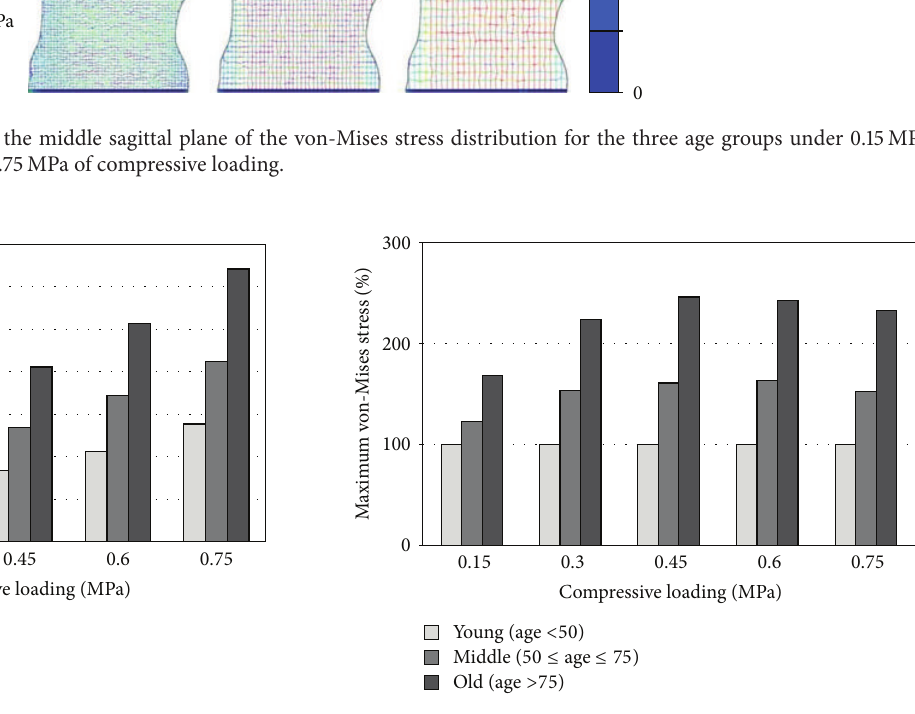
Figure 4: Maximum stress for the three age groups under 0.15 MPa, 0.3 MPa, 0.45 MPa, 0.6 MPa, and 0.75 MPa of compressive loading.